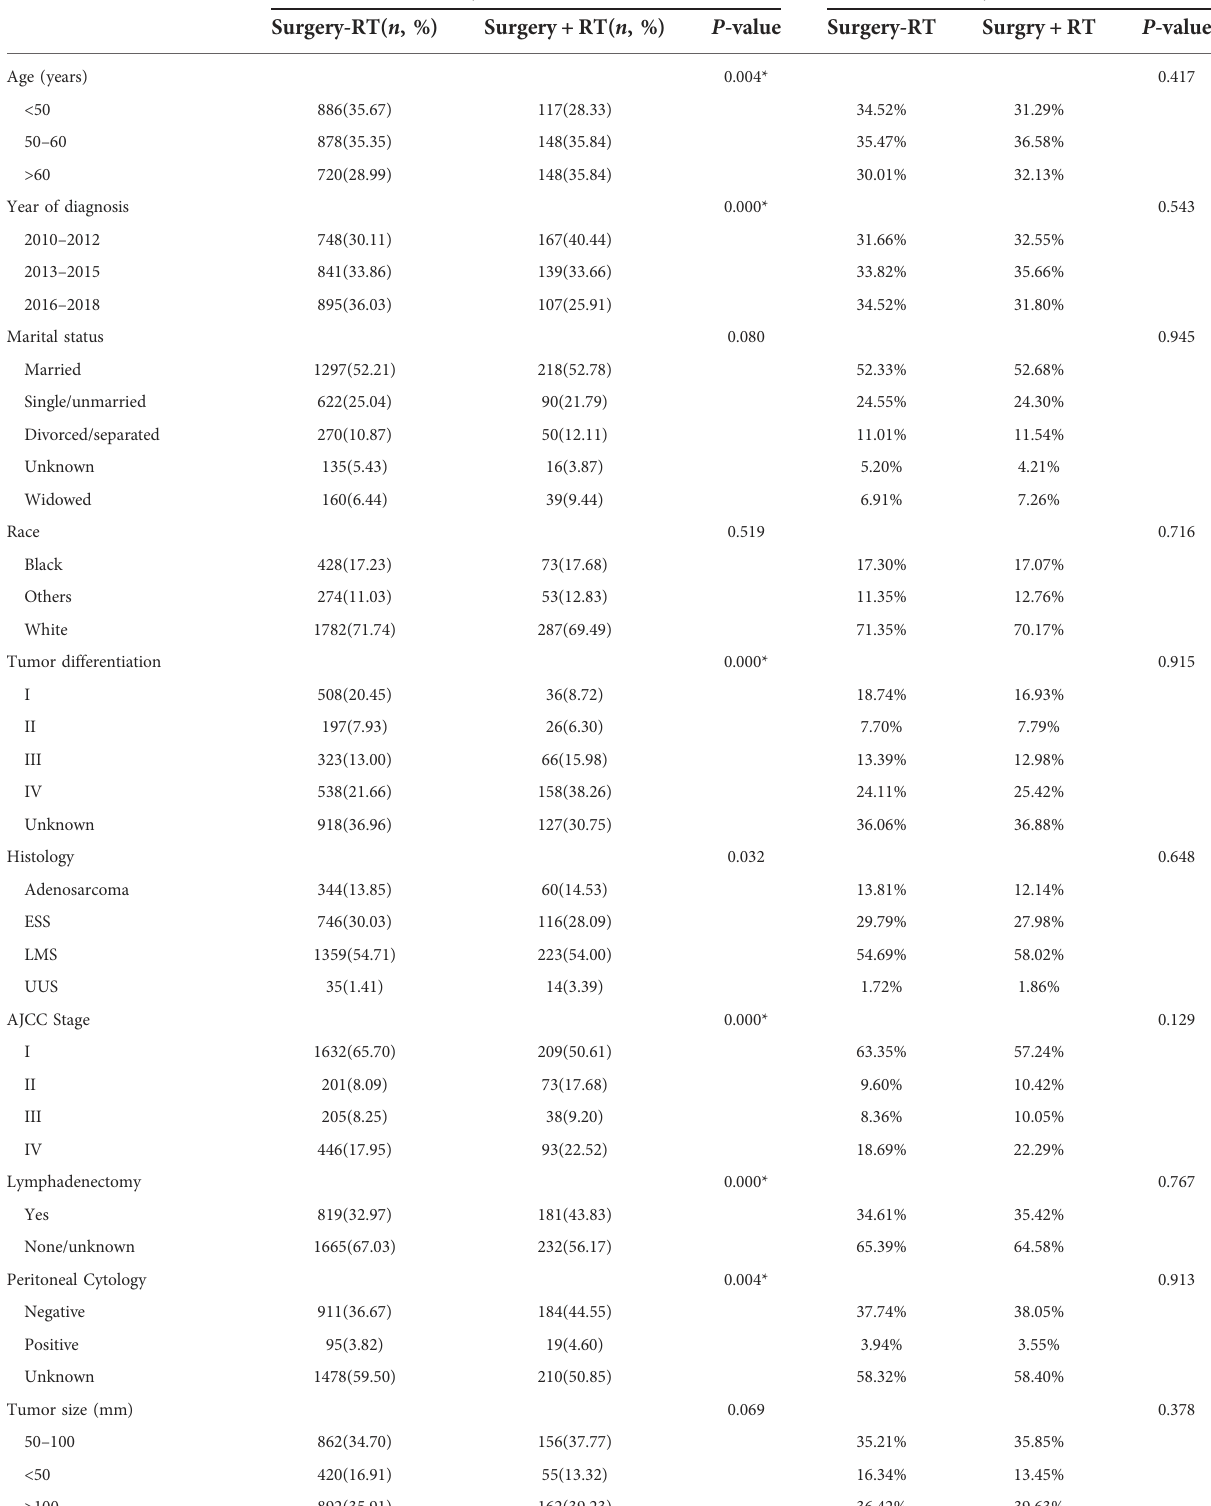
TABLE 2 Baseline characteristics in uterine sarcomas before and after IPTW-adjustment according to RT.